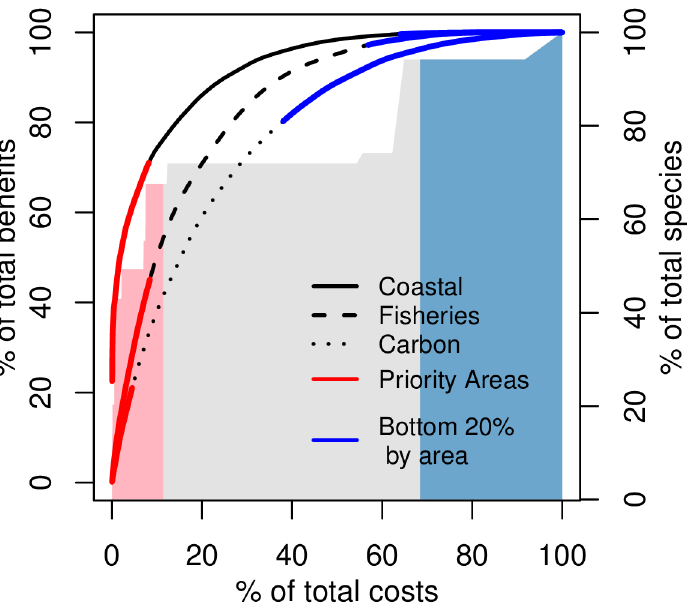
Fig 3. Percent of total cumulative ES benefits versus the percent of overall opportunity costs when managing each mangrove ES service objective; red and blue lines indicate the priority and bottom 20%-by-area for each service. Coloured polygons indicate the cumulative percent of the total number of mangrove associated species that would be protected by managing sites in order of their priority ranking.